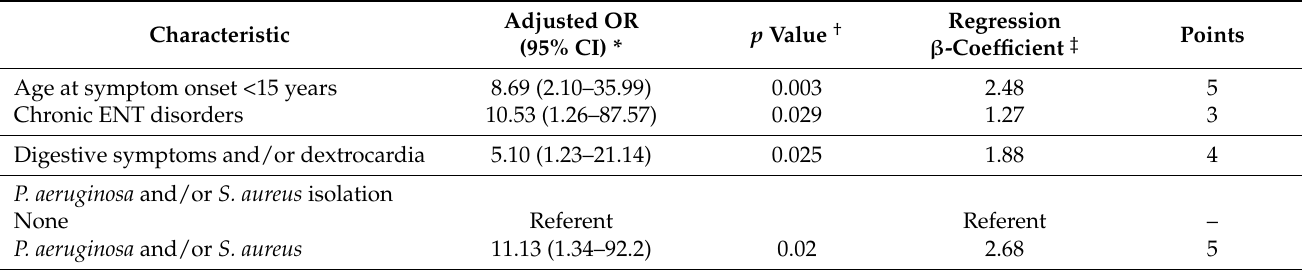
Table 2. Multivariate analysis and scoring system to predict cystic fibrosis or primary ciliary dyskinesia among adults with bronchiectasis ( n =